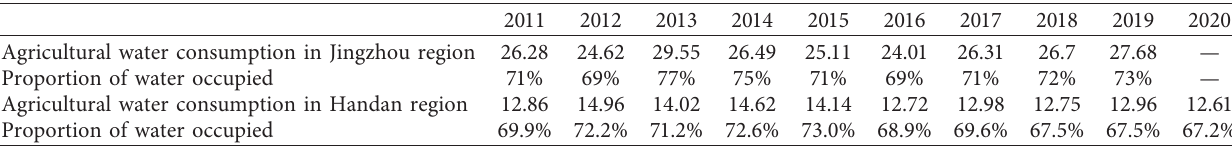
Figure 2: Location map of research area—Jingzhou. Table 1: Agricultural water consumption in Handan and Jingzhou from 2011 to